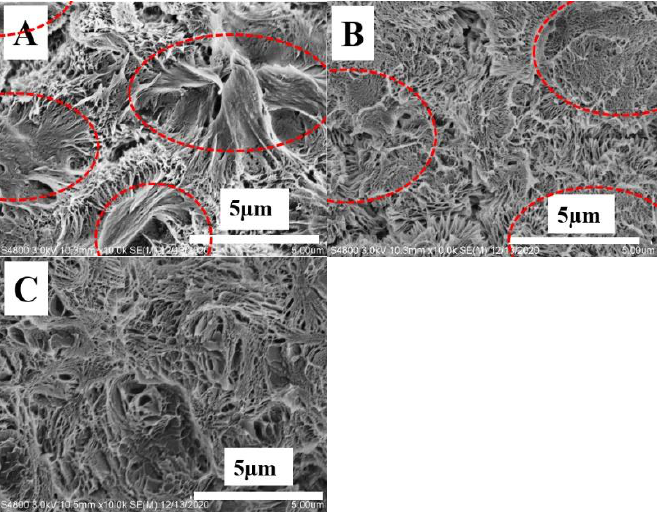
Figure 8. SEM images of PLLA/TAIC (60/40) blend upon etching with methanol on the specimen upon complete cold crystallization at 60 °C ( A ), 80 °C ( B ), and 100 °C ( C ).